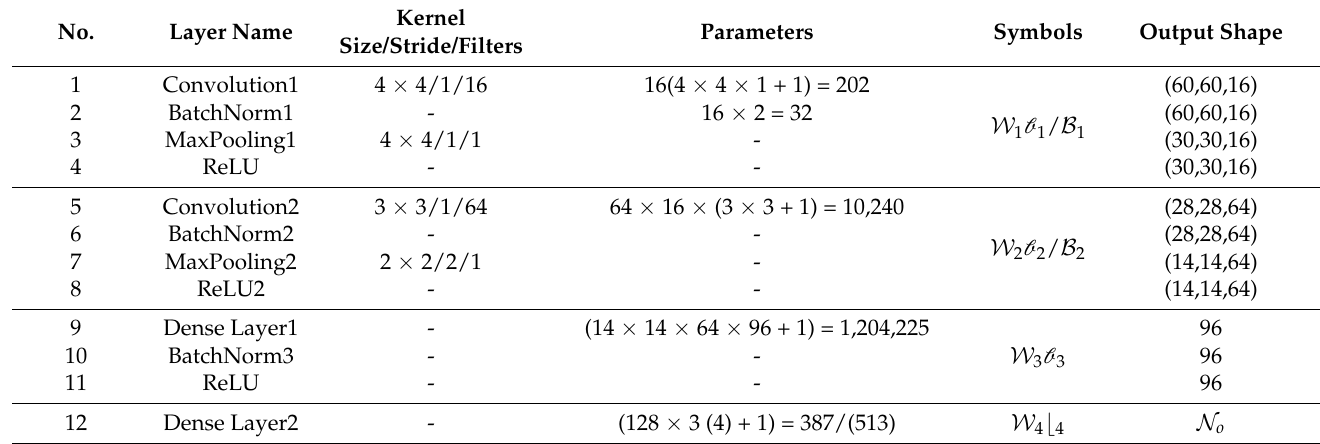
Table 1. Details of the classifier.